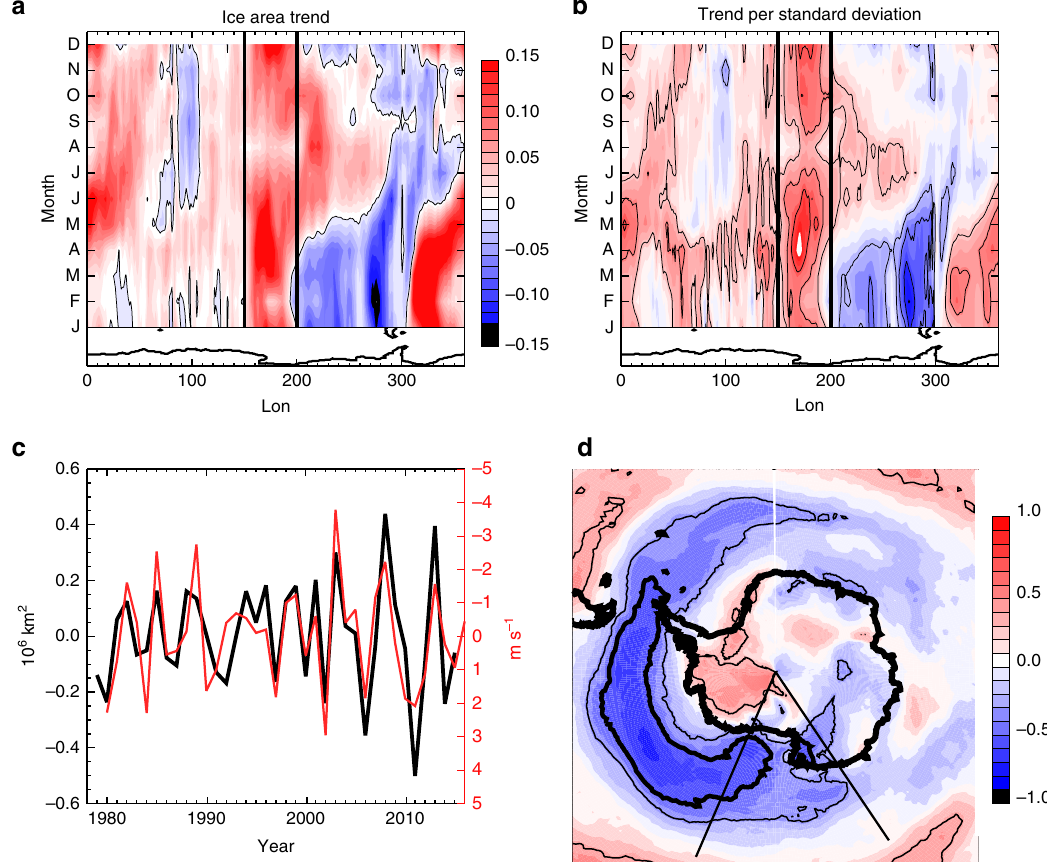
Fig. 1 Observed sea ice properties and relationship to October zonal winds. a Sea ice area trend in 10 6 km 2 per 37 years, from 1979 to 2015 as a function of longitude (at every 1.125 o ) and month. b Sea ice area trend relative to the interannual standard deviation as a function of longitude and month. The lined contour interval is 1 standard deviation. The zero contour is omitted. c The timeseries of March sea ice area anomalies in the 150 – 200 º E region ( black ; left axis) and the averaged preceding October zonal wind anomaly index ( red ; right axis). The two timeseries have been detrended. d The correlation of the preceding gridded October zonal wind anomalies with the March western Ross Sea ice area. The thin lined contour indicates the 95% signi fi cance level. The zonal wind index timeseries shown in c is the average over the region of high negative correlation ( R < − 0.5) that is indicated by the bold black contour on d . The 150 – 200 º E region is indicated on d by the thin black